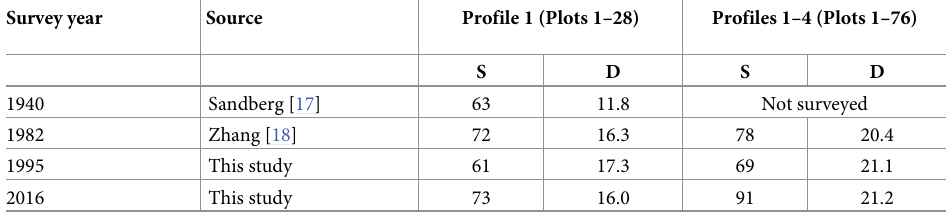
Table 1. Total species richness (S) and inverse Simpson diversity (D) in Profile 1 (1940–2016) and all profiles (1982–2016). Note that in 1940 only Profile 1 was